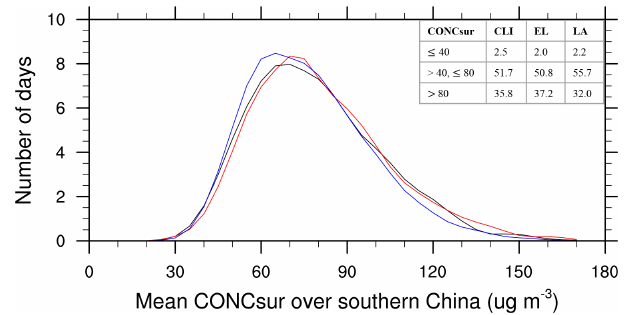
Figure 10. Frequency distributions of the simulated winter daily surface aerosol concentrations (CONCsur; units: µgm − 3 ) averaged over southern China (after being amplified by 10), with black, red, and blue lines representing the results from CLI, EL, and LA, re- spectively. The average numbers of days in winter with CONC- sur ≤ 40, 40 < CONCsur ≤ 80, and CONCsur > 80 in CLI, EL, and LA are given in the table at the top right